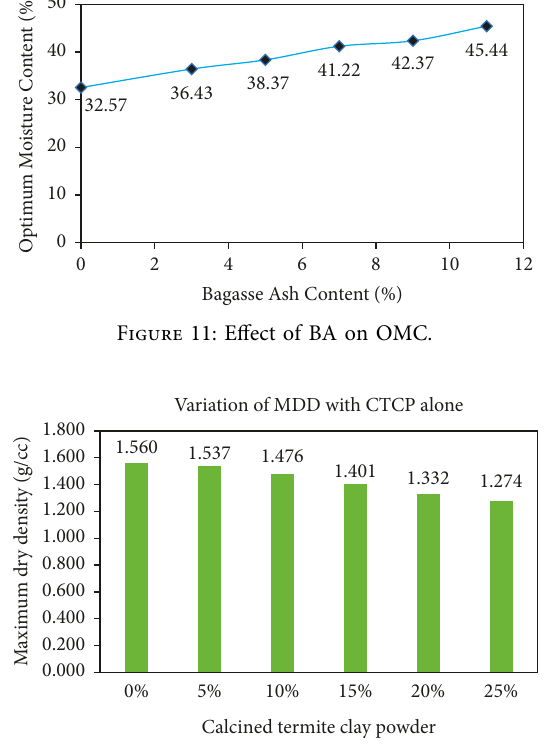
Figure 12: Effect of CTCP on MDD.